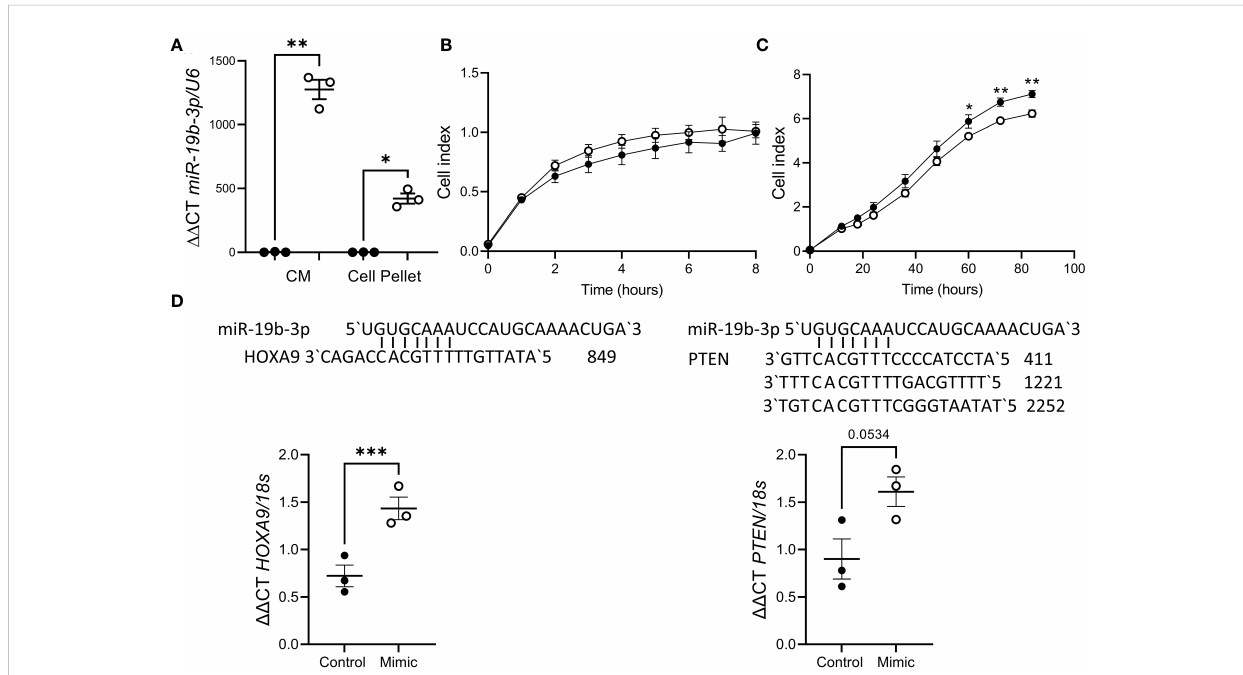
FIGURE 3 miR-19b-3p overexpression in HTR8/Svneo cells impaired proliferation. (A) Treatment with miR-19b-3p mimic ( ○ ) signi fi cantly increased miR-19b- 3p levels in HTR8/Svneo culture media (CM) and cell pellet compared to scramble control ( ● ). (B) miR-19b-3p mimic had no effect on HTR8/Svneo adhesion (n=3/group). (C) miR-19b-3p mimic signi fi cantly reduced HTR8/Svneo proliferation after 60h (n=3/group). (D) miR-19b-3p mimic signi fi cantly increased HOXA9 expression but had no effect on PTEN . Alignment of miR-19b-3p and the 3`UTR of HOXA9 and PTEN is also shown. Data shows mean ± SEM; *P<0.05; **P<0.01; ***P<0.001; (A – C) , repeated measures ANOVA; (D) , paired